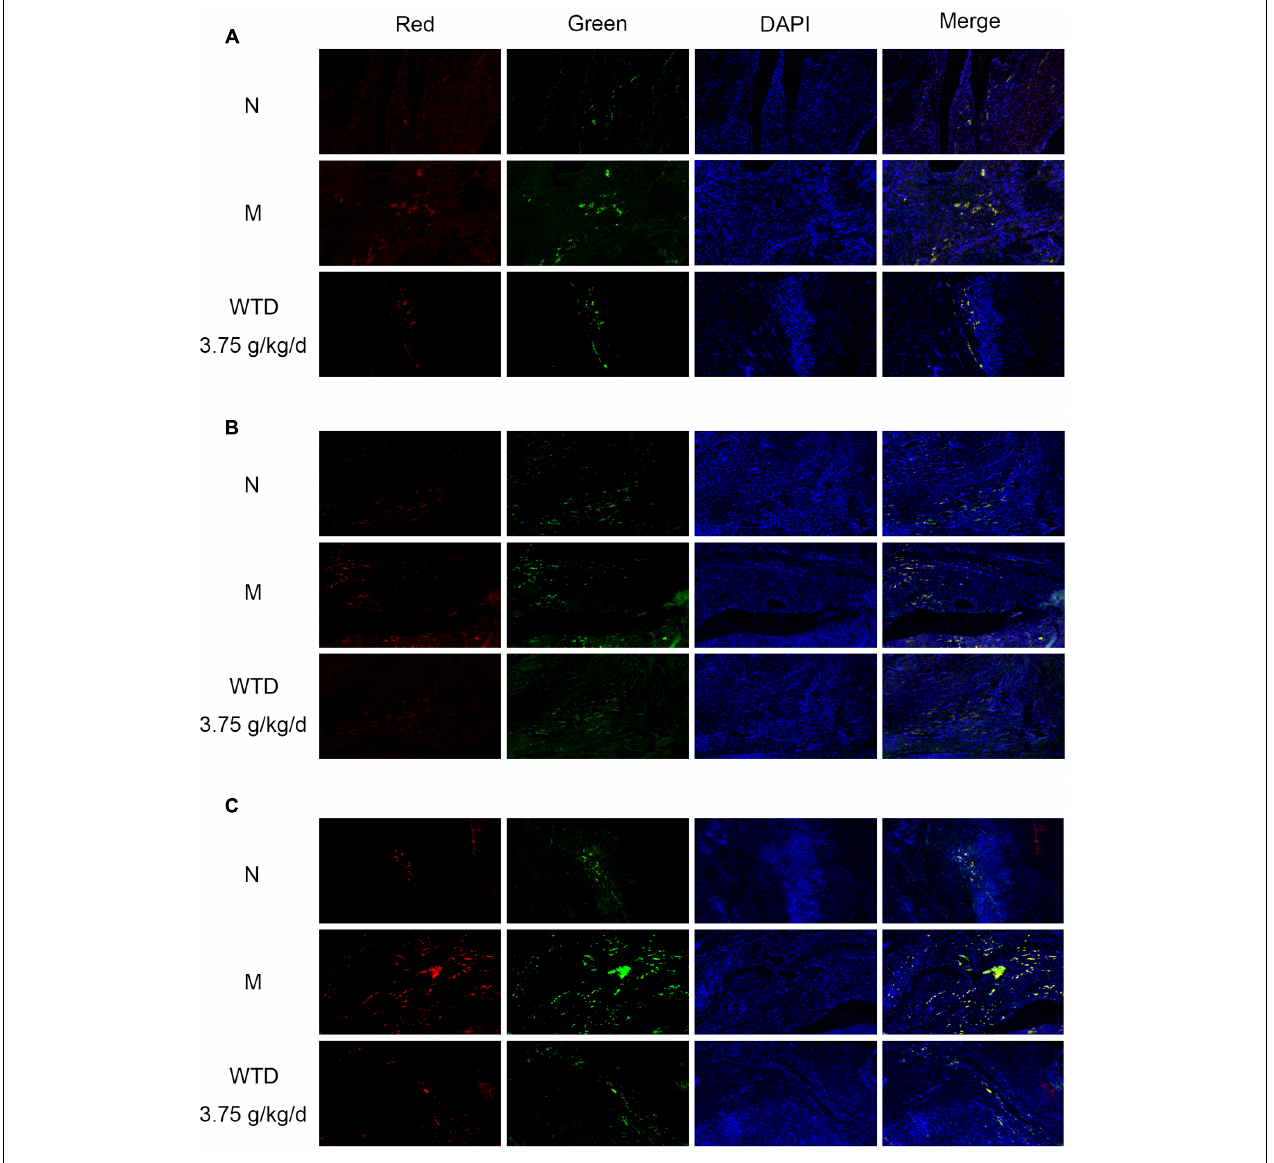
FIGURE 8 | Effects of WTD on phosphorylation levels of CCR5, PKC δ , and p38 in macrophages in ankle joints of CIA rats. Representative immunofluorescence images of p-CCR5 (A) , p-PKC δ (B) , p-p38 (C) (red) and CD68 (green). Original magnification 100 ×